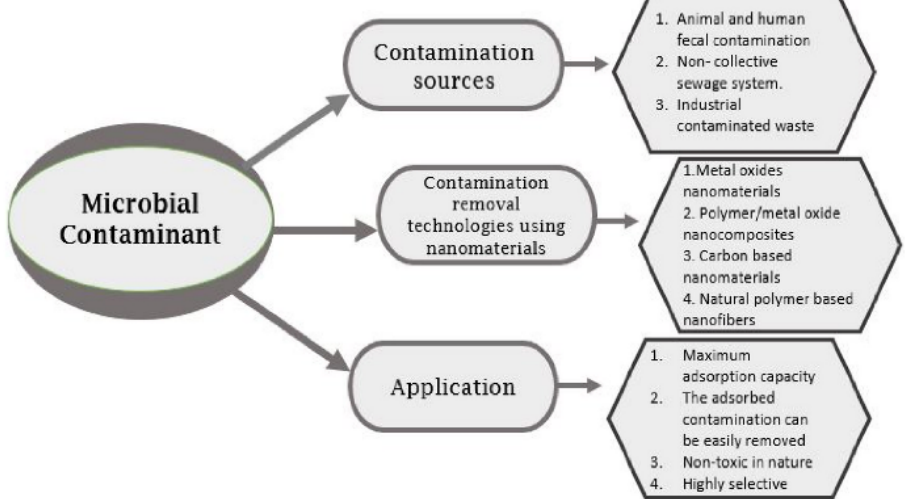
Figure 7. Schematic representation of microbial contamination sources and their various nanomaterials for water treatment. Reprinted/adapted with permission from Ref. [76]. Copyright © 2022, Elsevier Ltd.